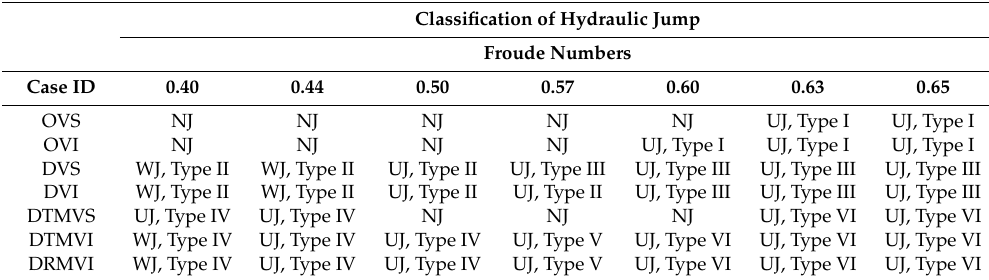
Figure 6f. The graphical representation of experimental results of DRMVI against all the values of the selected range of initial Froude number ( Fr o ) is shown in Figure 8c. The variation of length of the hydraulic jump can be represented by the relative length of the hydraulic jump ( L j / y 1 ) [48]. In these cases, the relative length of the hydraulic jump ( L j / y 1 ) increased by increasing Fr o and the maximum relative jump was noted in the case of DTMVI as compared to DTMVS and DRMVS, as shown in Figure 9. Table 2. Hydraulic jump classification of SDS and